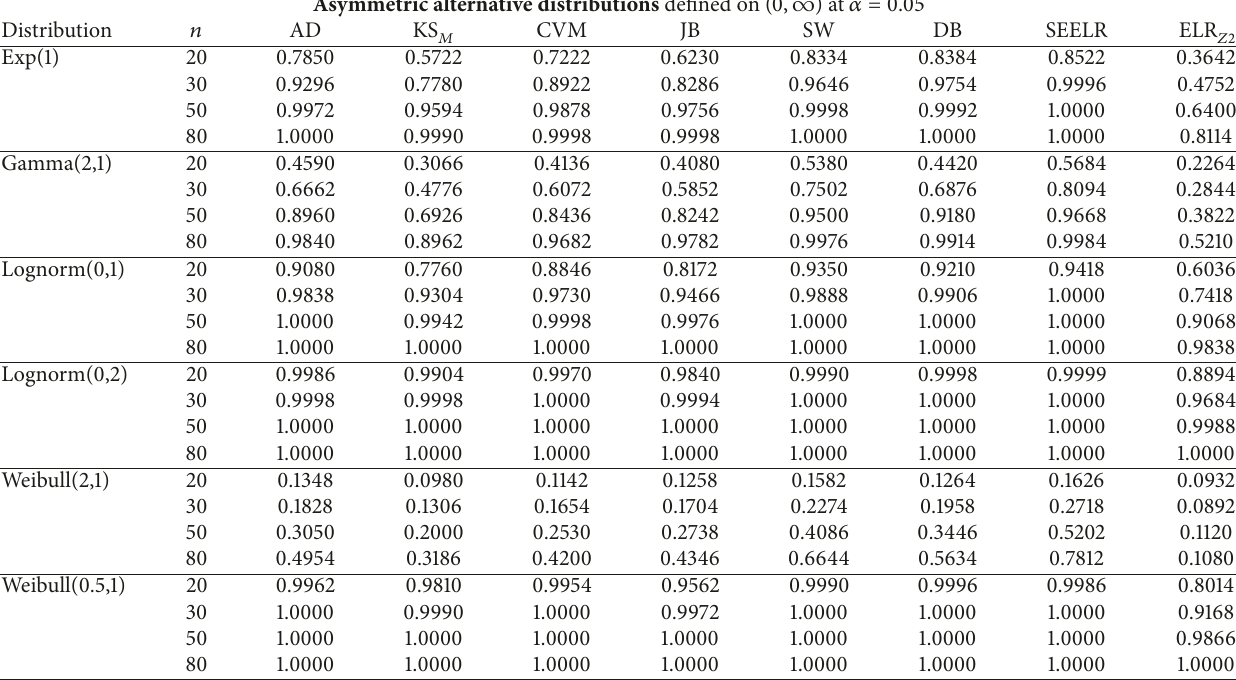
Table 7: Results of the Monte Carlo power comparisons based on samples with sizes (𝑛) from asymmetric alternative distributions defined on (0, ∞) at 𝛼 = 0.05 .